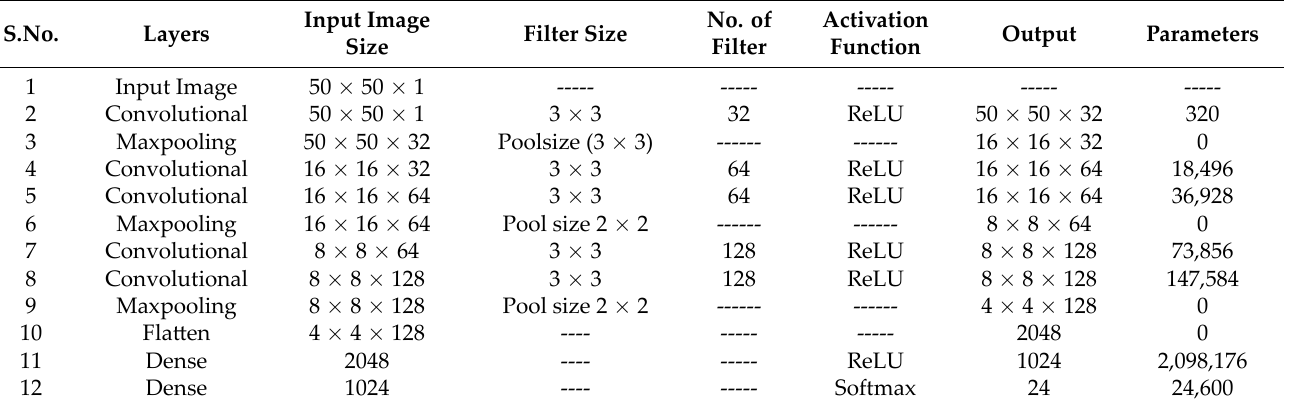
Table 2. Details of layers of proposed CNN model.